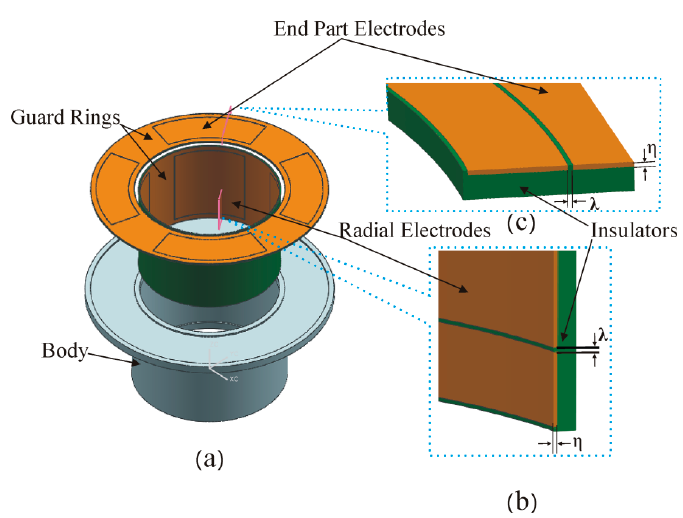
Figure 2. Schematic of the stator: ( a ) The exploded view of the structure; ( b , c ) partial cross-sectional view of the stator.